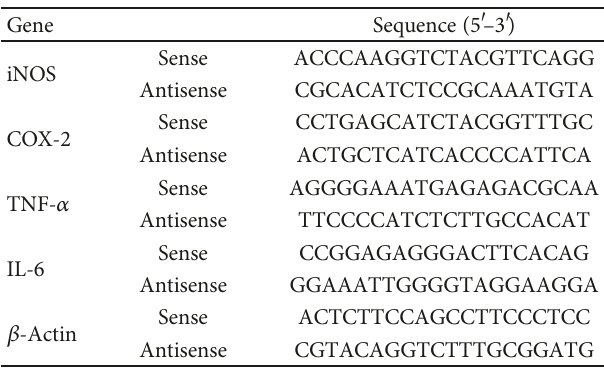
Table 3: PCR primers used in this